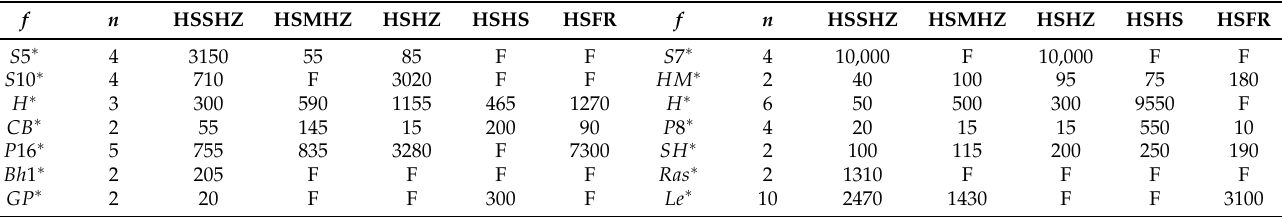
Table 9. The number of worst iterations.